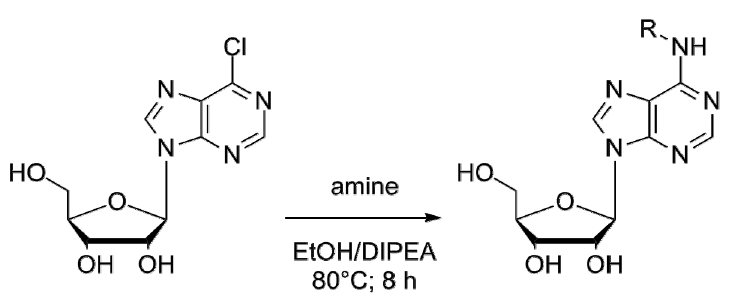
Figure 8. General scheme of synthesis of series 1.